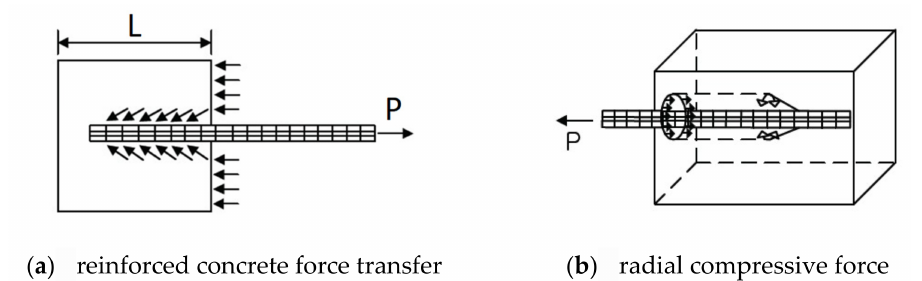
Figure 12. Rebar force transition structure